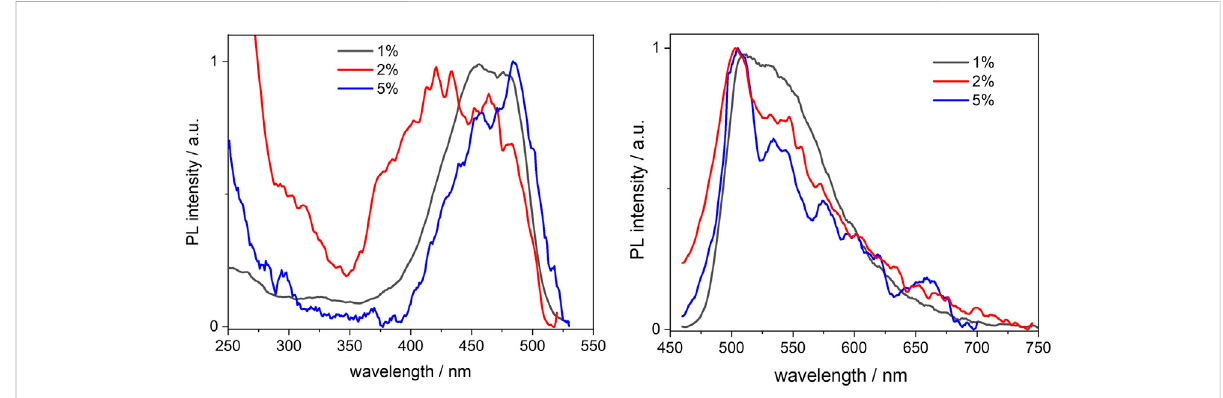
FIGURE 5 Normalised excitation (left) and emission (right) spectra of the BOPHY1-PMO samples, recorded from 0.3 mg/ml cyclohexane suspensions at λ λ em = 540 nm and exc = 420 nm,